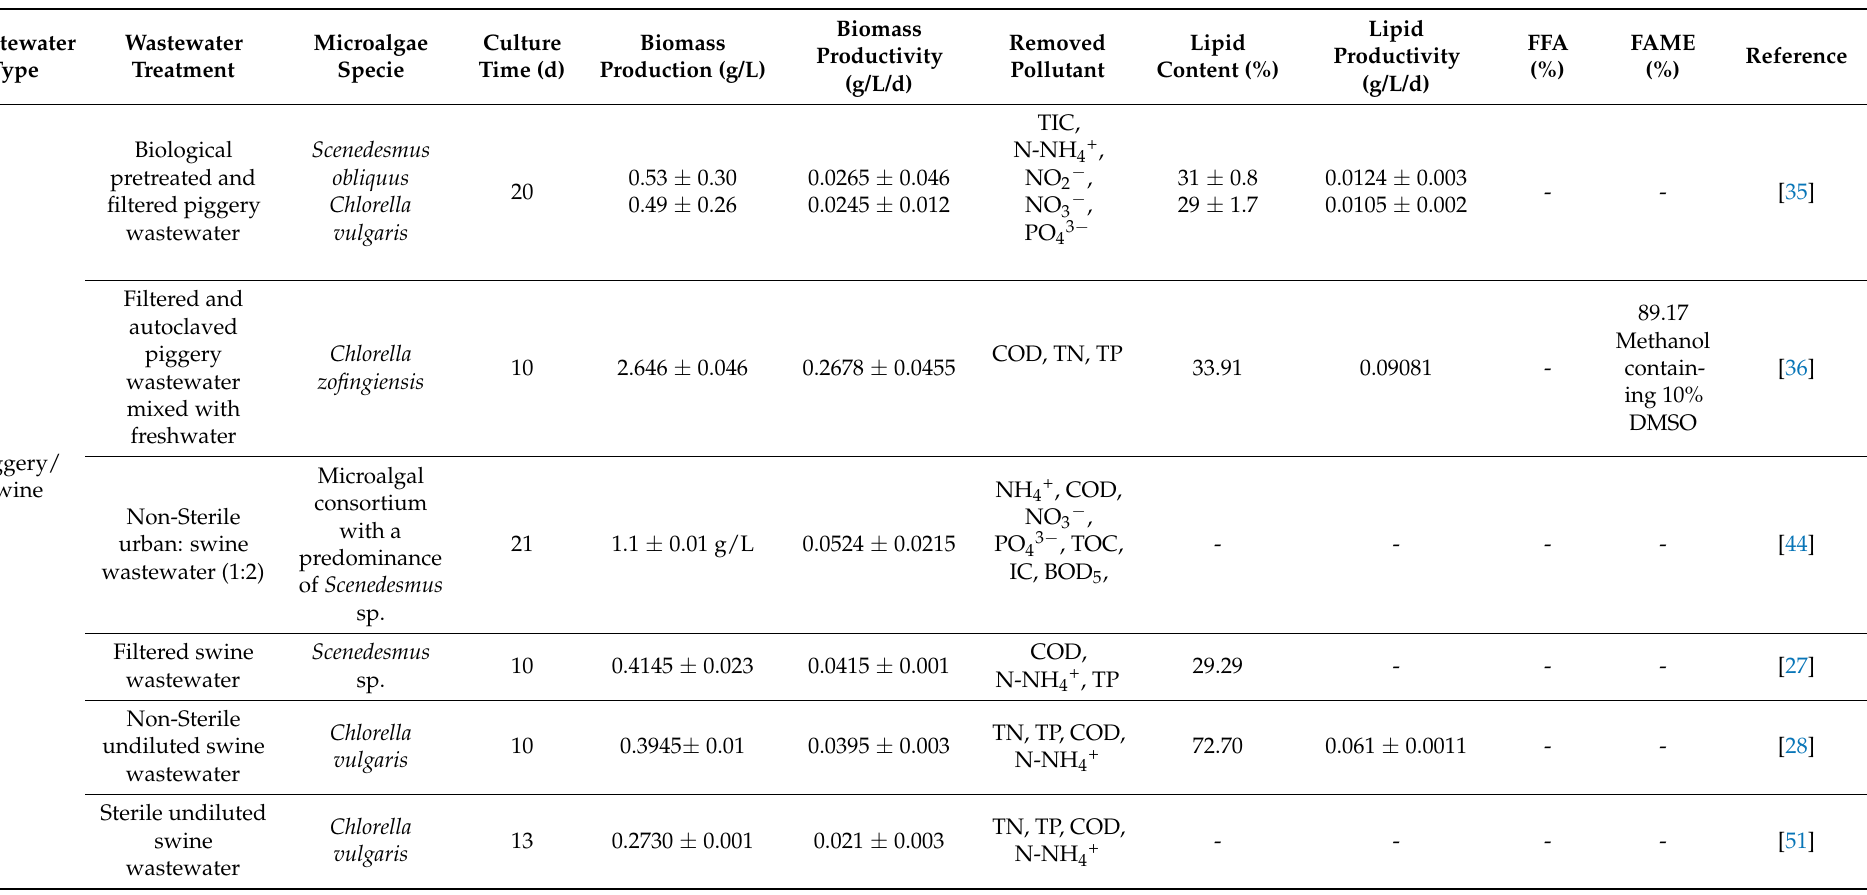
Table 2. Summary of literature using piggery/swine wastewater for microalgae biomass